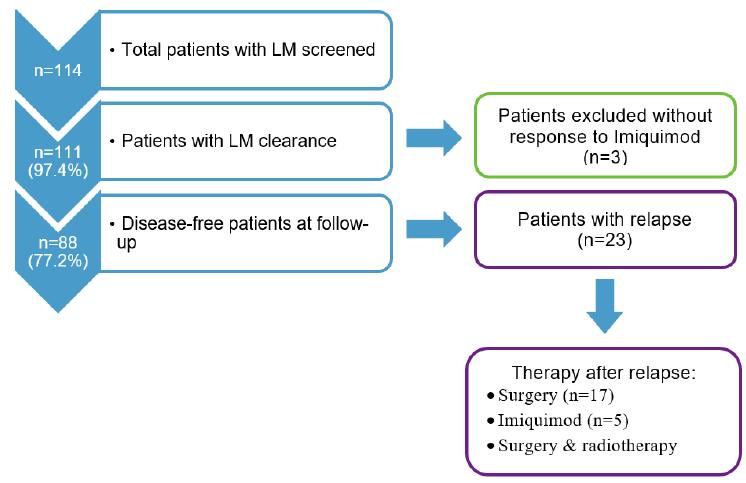
Figure 1. Flowchart of the study cohort selection and follow-up.